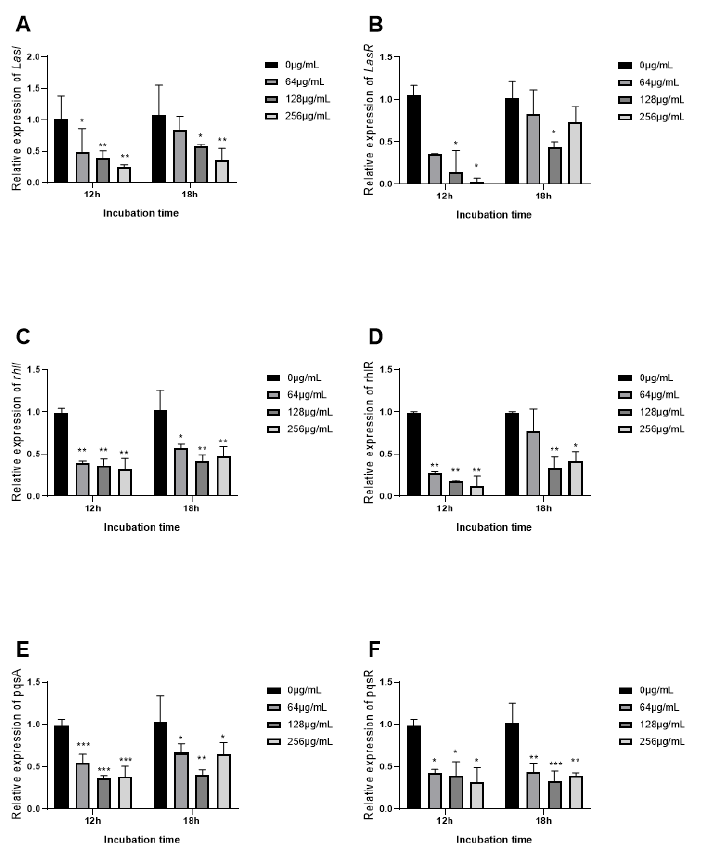
Figure 10. Effects of EGCG on the expression of QS genes compared with untreated control at 12 h and 18 h. (( A ) LasI; ( B ) LasR; ( C ) rhlI; ( D ) rhlR; ( E ) pqsA; ( F ) pqsR). (All data are representative of three independent experiments performed in triplicate and expressed as the mean ± SD values in each bar. * p < 0.05; ** p <0.01; *** p < 0.001).